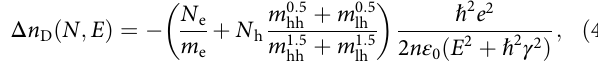
Fig. 4b, the calculated dynamics of the real part of the refractive index is given. The non-exponential behaviour of Δ n is in Fig. 4 Full-wave simulation results. Transient re fl ectance spectra obtained